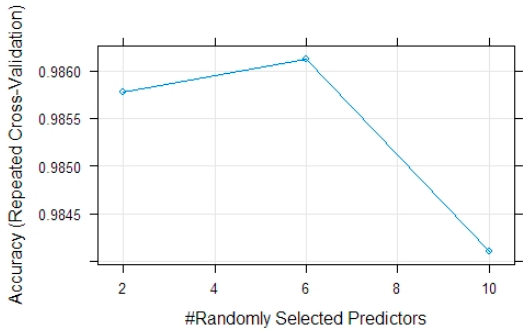
Figure A2. Cross-validation for the classification of Sentinel-2 imagery in 2019 with tested mtry = 2, 6, and 10. Mtry = 6 was selected for its highest accuracy.